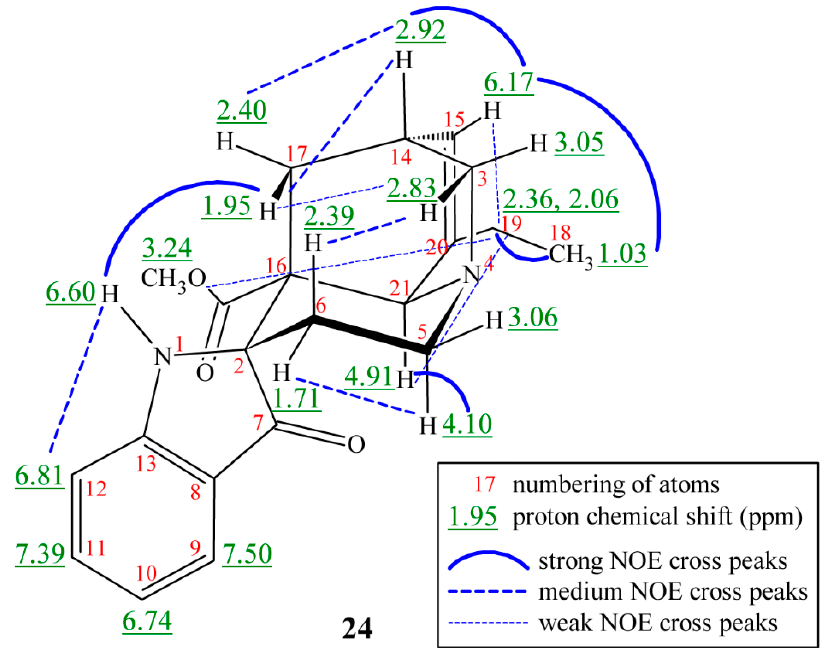
Figure 3. The three-dimensional structure of the spiro derivative of catharanthine ( 24 ).